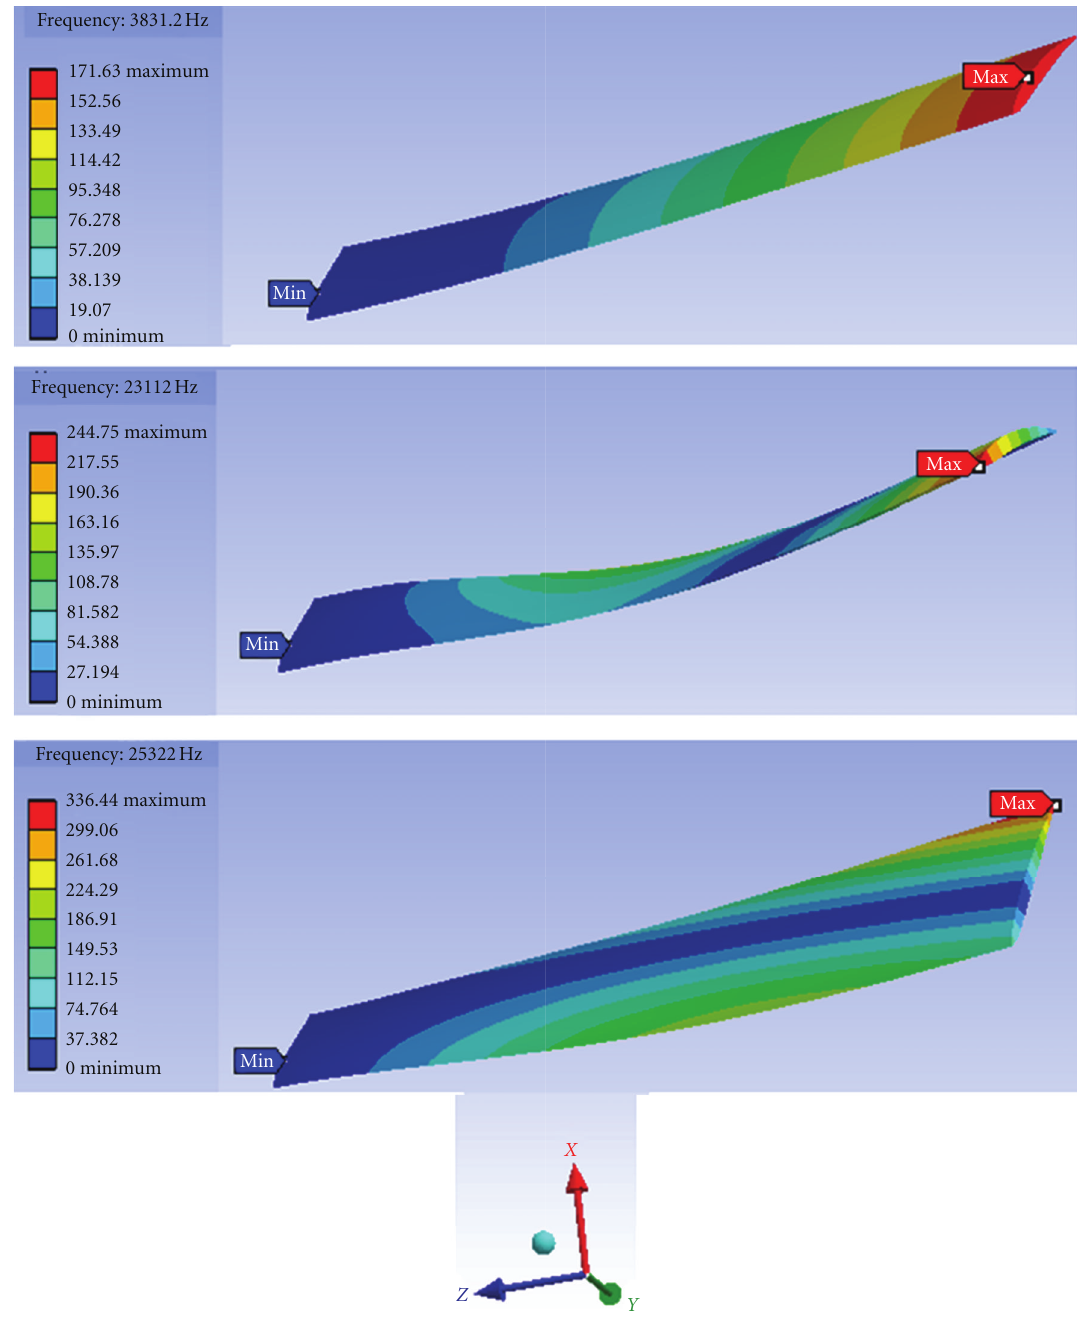
Figure 7: The first 3 mode shapes of the blade: top (pure bending), middle, a mixture of bending and torsion, and bottom, pure torsion.